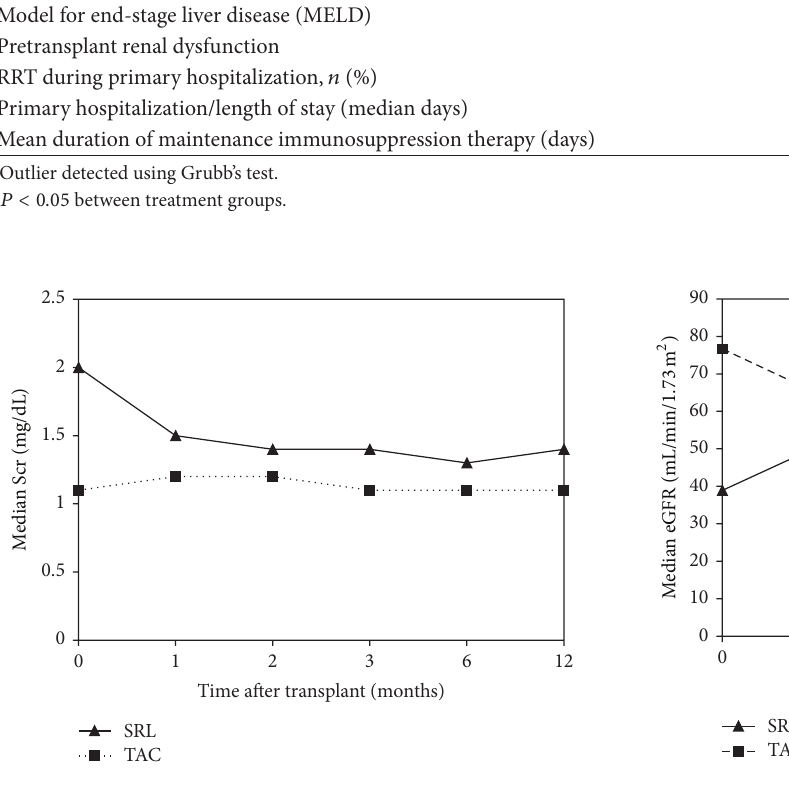
Figure 2: Comparison of estimated glomerular filtration rate between SRL ( 𝑛 = 29 ) and TAC ( 𝑛 = 168 ) groups over 1-year follow- up after transplant ( 𝑃 < 0.05 at months 0, 1, 3, 6, and 12).